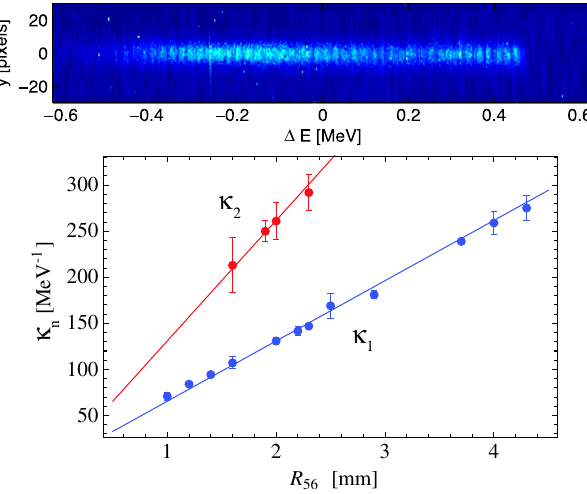
FIG. 3 (color online). Top: Observed e-beam distribution at the energy spectrometer for R 56 ¼ 4 . 3 mm. Bottom: Measured en- ergy banding frequency as a function of dispersion for the n ¼ 1 (blue) and n ¼ 2 (red) frequency zeros κ n in the banding spectrum. Points are from measurements with 3 σ error bars, and the lines are κ n ¼ nk 1 R 56 =E 0